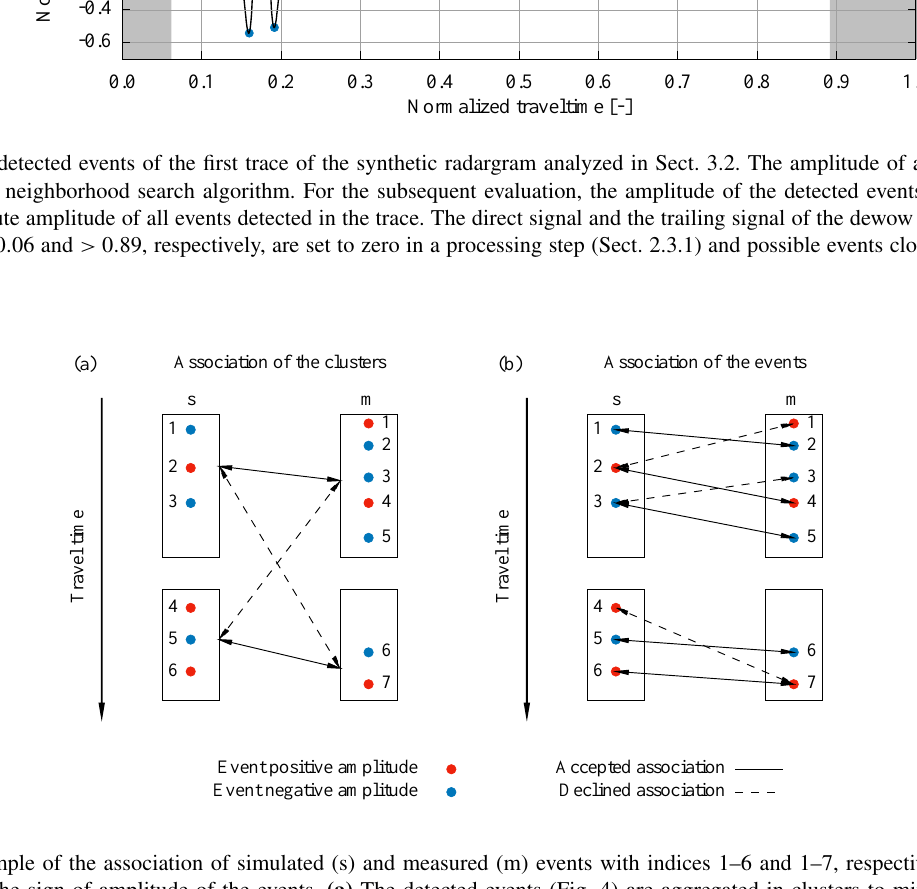
mented by the pyDOE package, https://github.com/tisimst/